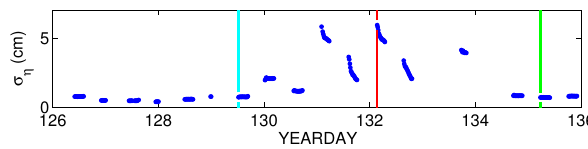
Figure 6. RMS bed roughness, σ η , from the bed profiles measured with the rotary pencilbeam sonar. Compare to the forcing time se- ries, Figure 5. The vertical cyan, red and green lines correspond to the times indicated in Figure 7.